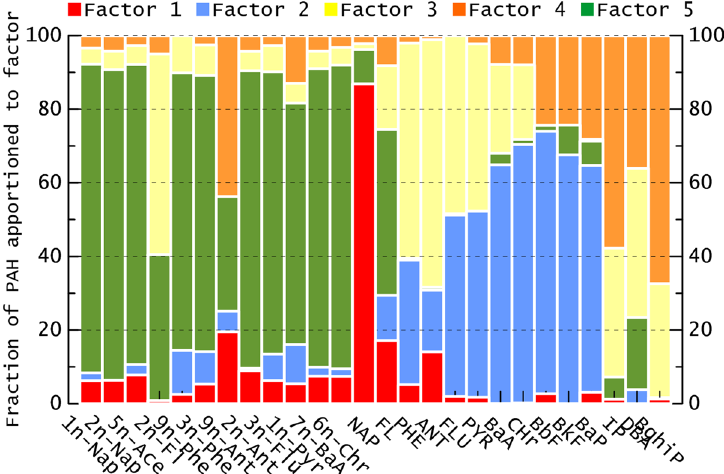
Figure 4. Five-factor loadings by PMF analysis from PAHs data of parent PAHs and nitro-PAHs in PM2.5 from 9 urban